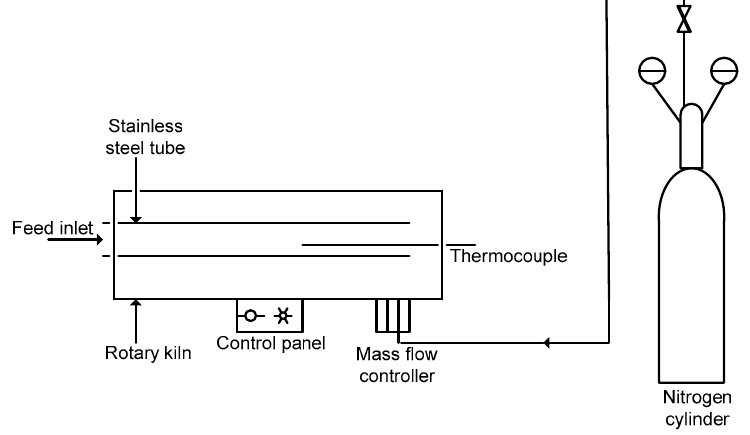
Figure 2. Simplified process schematic of the rotary kiln and gas control manifold.